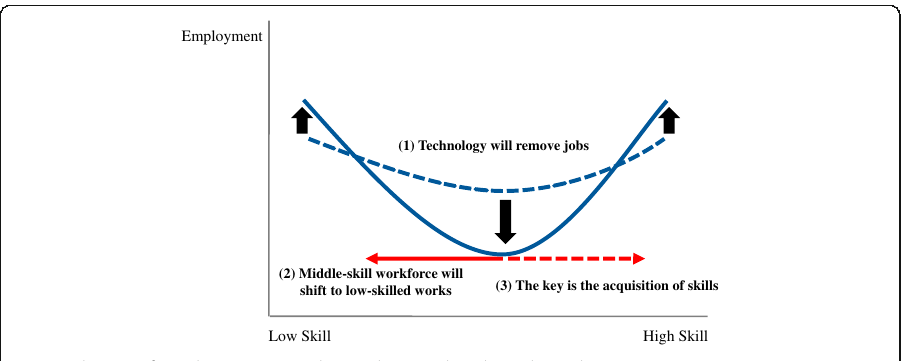
Fig. 4 Change of Employment Type due to the Fourth Industrial Revolution